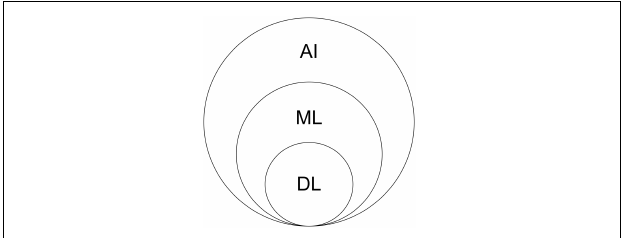
FIGURE 1 | Schematic representation of the hierarchical relationship between AI (which, in general, describes systems capable of imitating human behavior), ML (a subset of AI, which describes systems capable of learning by experience), and DL (a subset of ML, which describes systems based on neural